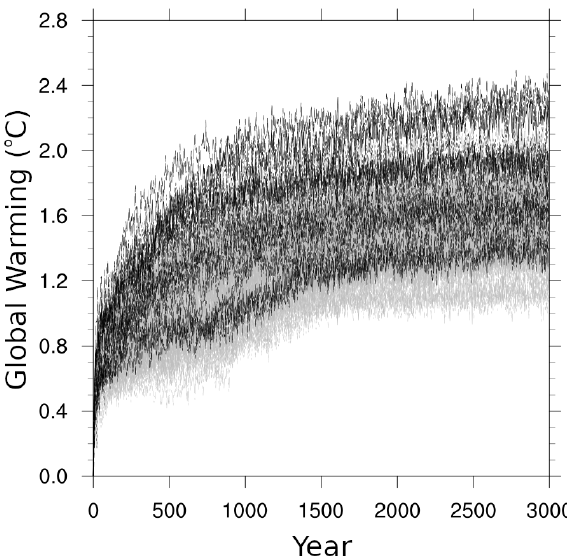
Figure 16. The mean global equilibrium warming projected by the selected 55 ensemble members (black lines) and the 500 inception simulations (grey lines) in the ECS experiment (refer to the text for